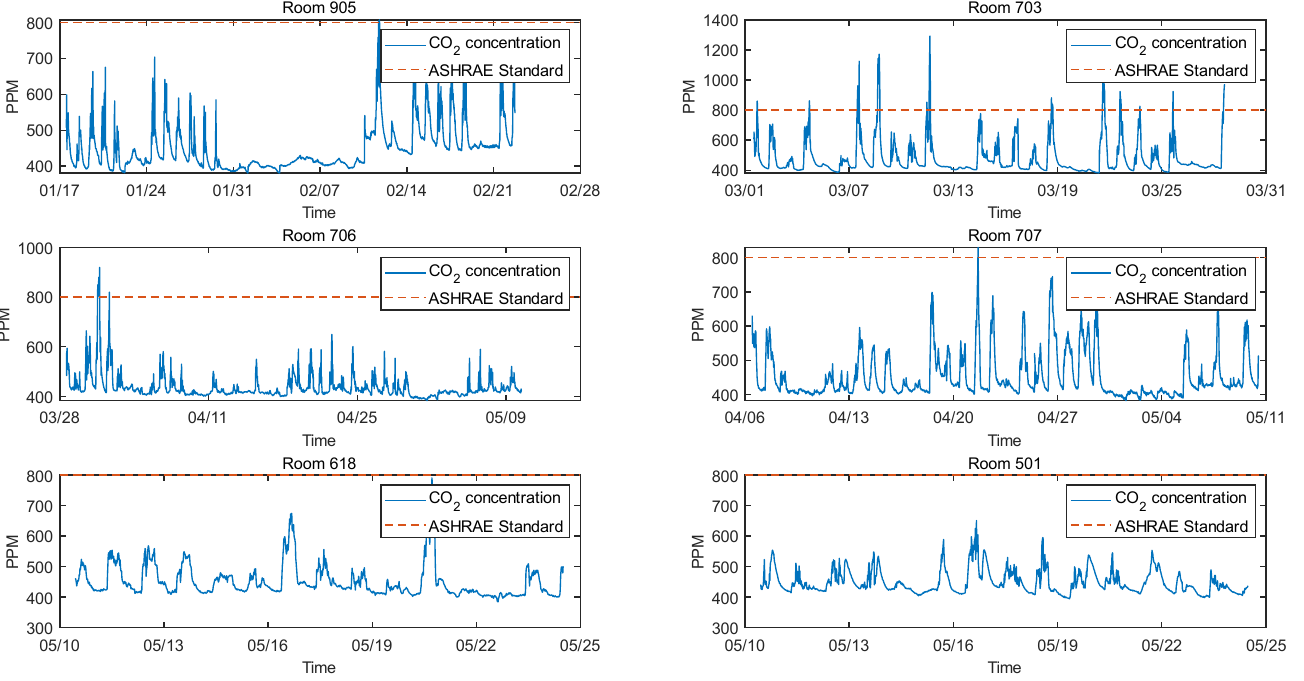
Figure A1. Real-time CO 2 monitoring of the 6 room.